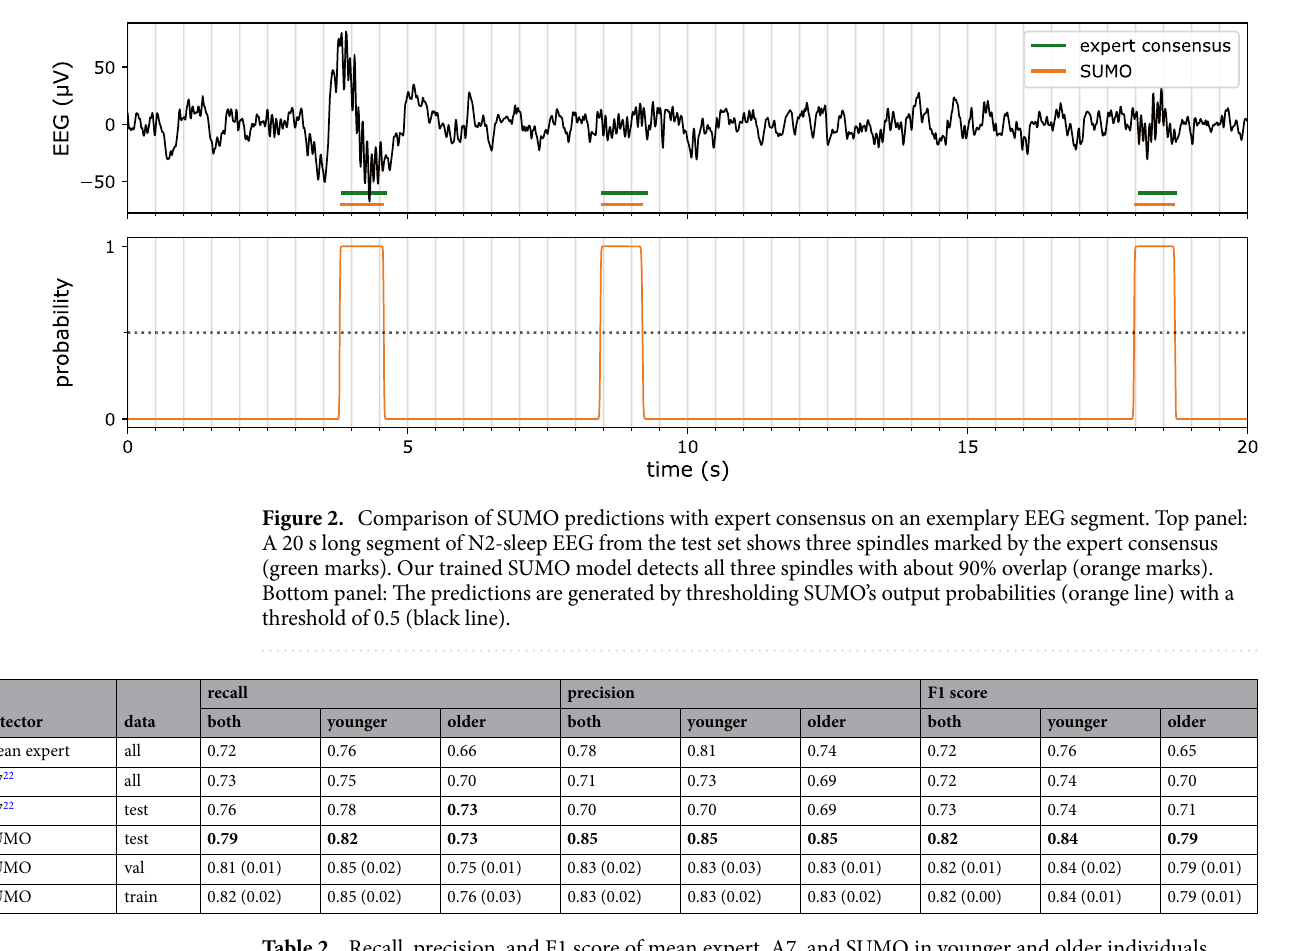
Table 2. Recall, precision, and F1 score of mean expert, A7, and SUMO in younger and older individuals. Our best SUMO model numerically exceeds the mean-expert and A7 scores in all categories. The test